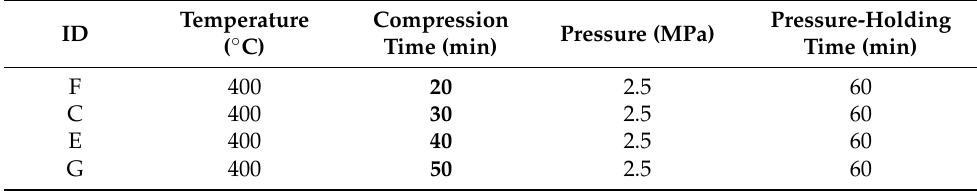
Table 3. Process parameters for different hot compression time scenarios.